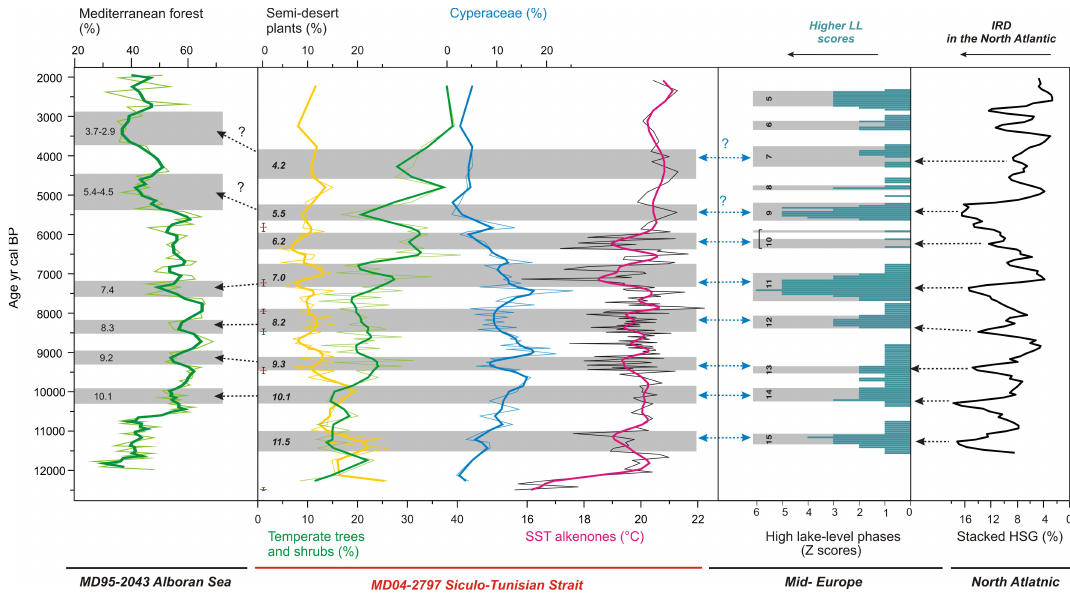
Fig. 7. Comparison of the centennial-scale variability recorded in core MD04-2797CQ with changes detected in the Western Mediterranean, middle latitudes of Europe and North Atlantic. From left to right: Mediterranean forest pollen percentages from core MD95-2043 (Fletcher and S´anchez Go˜ni, 2008): 3-points moving average (bold green line) with forest reduction episodes indicated by the grey bars as in Fletcher et al. (2012); MD04-2797CQ pollen percentages and alkenone-SSTs (bold lines: cubic smoothing splines with a degree of freedom adjusted to highlight the centennial-scale changes) with abrupt vegetation and SST changes as described in the text; red and black symbols denote radiocarbon age control of core MD04-2797CQ; Mid-European lake level (LL) changes with high lake level phases as indicated in Magny (2013); Stacked Hematite Stained Grains (% HSG) from North Atlantic records (Bond et al.,